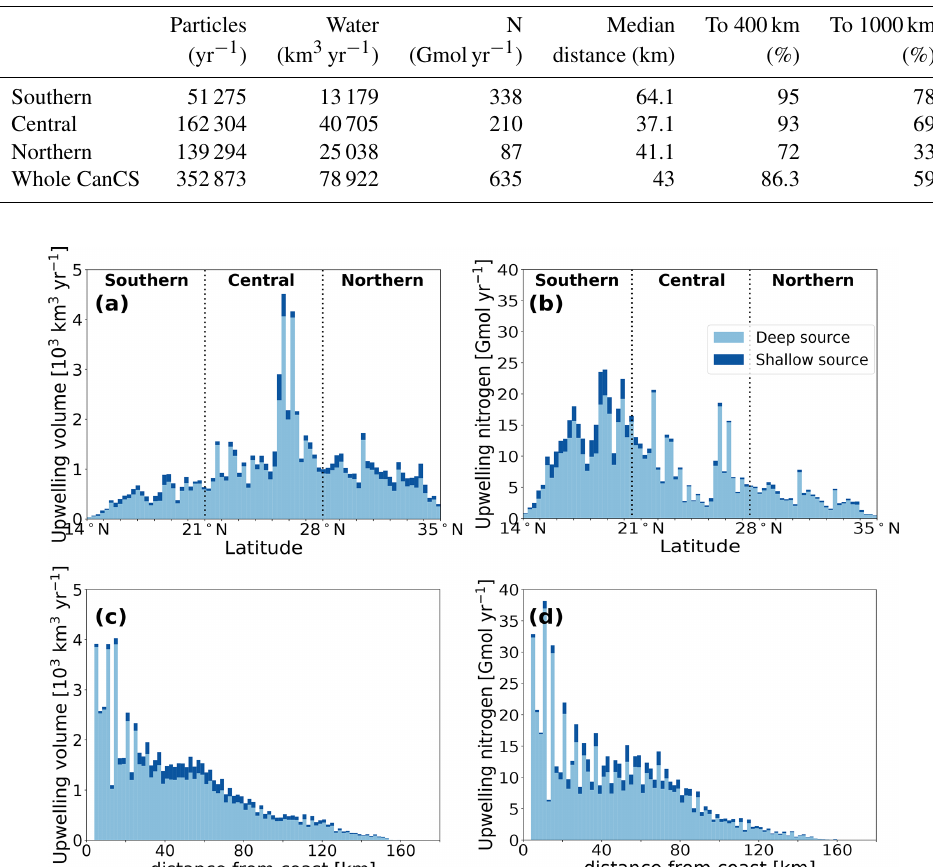
Figure 2. (a, b) Annual upwelling (a) water volume and (b) nitrogen zonally integrated across the coastal upwelling region (between the coast and 50km westward of the 200m bathymetry). (c, d) Annual upwelling (c) water volume and (d) nitrogen with distance from the coast in the whole CanCS upwelling domain (14–35 ◦ N). Light- and dark-blue segments represent contribution by deep and shallow sources of water,